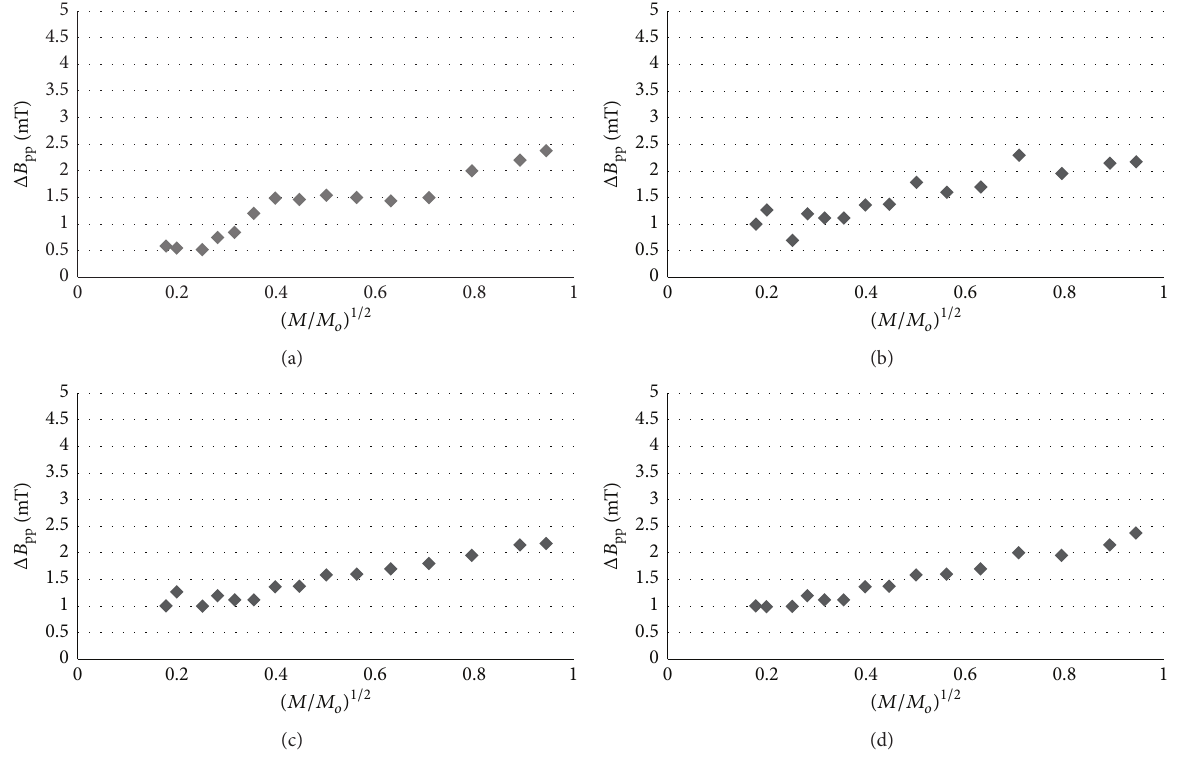
Figure 7: The effect of microwave power ( 𝑀/𝑀 𝑜 ) on linewidths ( Δ𝐵 pp ) of the EPR spectra of UV irradiated salicylic acid during (a) 15 minutes, (b) 30 minutes, (c) 45 minutes, and (d) 60 minutes. 𝑀 : microwave power used during the measurement and 𝑀 𝑜 : total microwave power produced by klystron (70